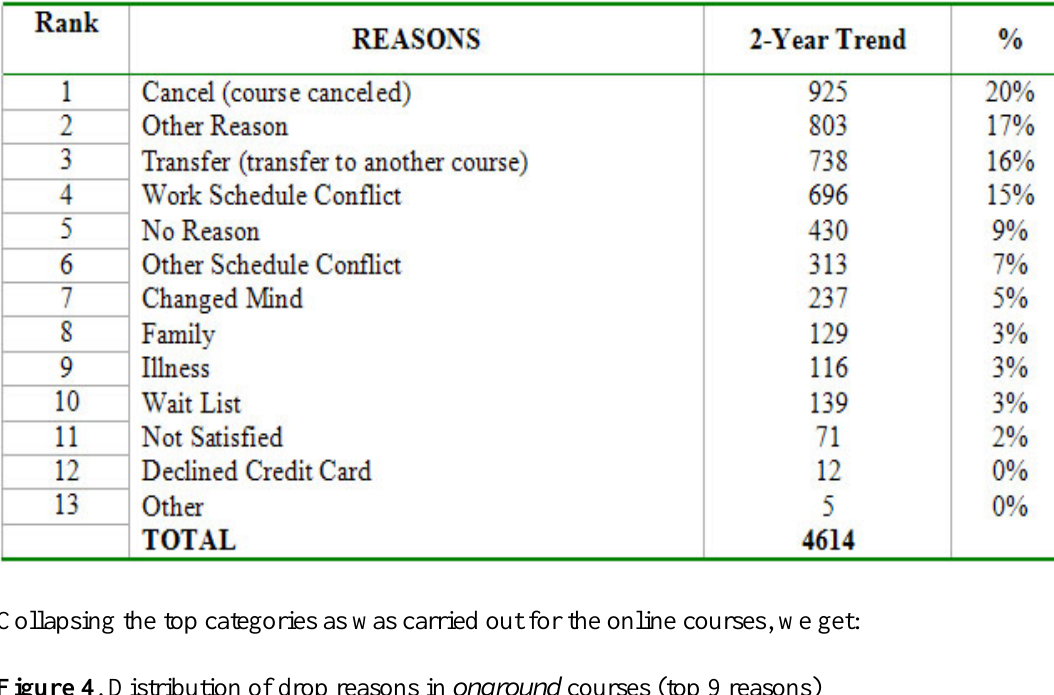
Table 9 . Reasons given for requesting withdrawal from onground courses